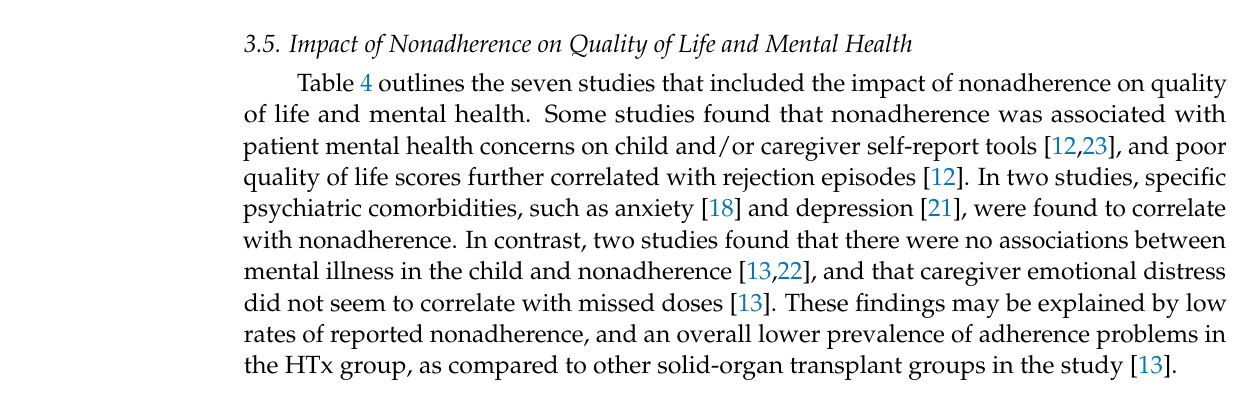
Table 4. Studies exploring impact of nonadherence on quality of life and mental